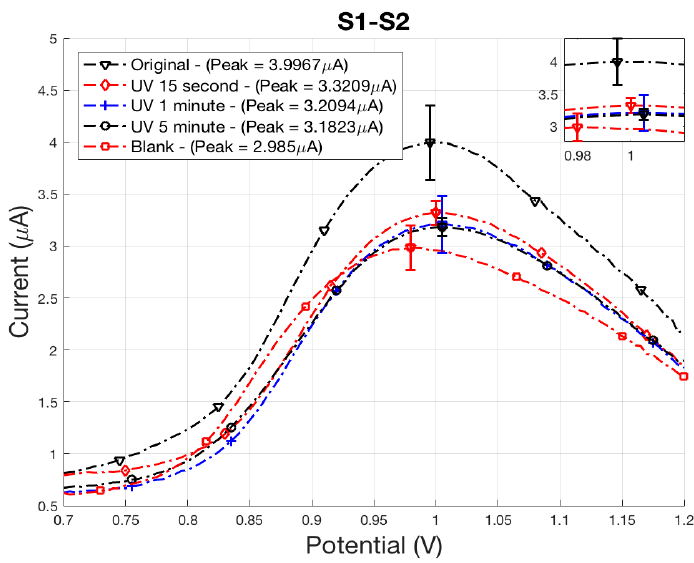
Figure 7. UV-treated E. coli electrochemical SWV curves displaying the oxidation of polyG tag.